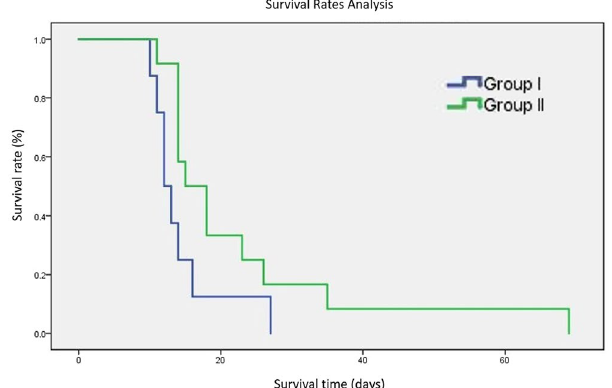
Figure 8. Survival rates analysis after trachea replacement surgery by Kanlan-Meier method and Breslow test. P =